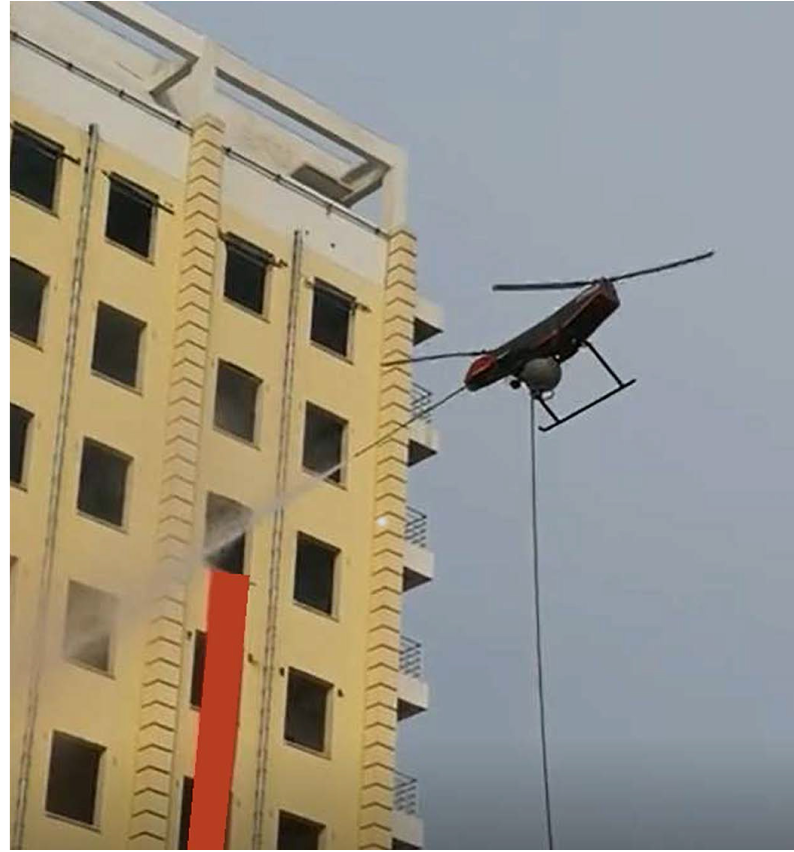
Figure 5. The fire extinguishing equipment at high